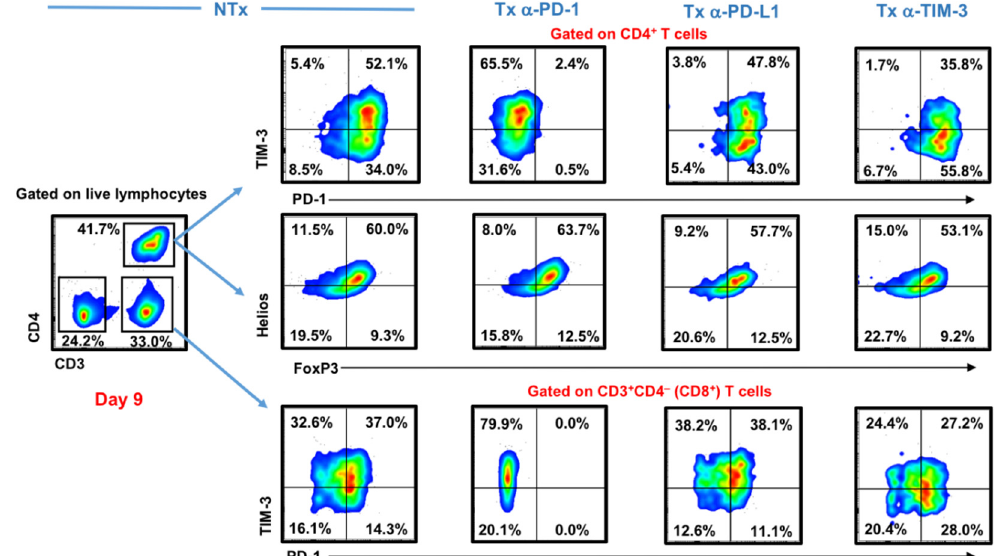
Figure 1. Effect of different immune checkpoint inhibitors on T cells in breast tumor explants. Tumor tissue from 2 breast cancer patients were cut into small pieces and cultured with exogenous interleukin-2 (IL-2), in the presence or absence of anti-programmed cell death protein 1 (PD-1), anti-programmed death ligand-1 (PD-L1), or anti-T cell immunoglobulin and mucin-domain containing-3 (TIM-3) monoclonal antibodies (mAbs). Cells were collected on Day 9 and stained with TIM-3, PD-1, and different T regulatory cell (Treg)-related markers. Representative flow cytometric plots show TIM-3 and PD-1 surface expression on CD3 + CD4 − (CD8 + ) and CD3 + CD4 + T cells, as well as intracellular FoxP3 and Helios expression on CD3 + CD4 + T cells from different treatment conditions.